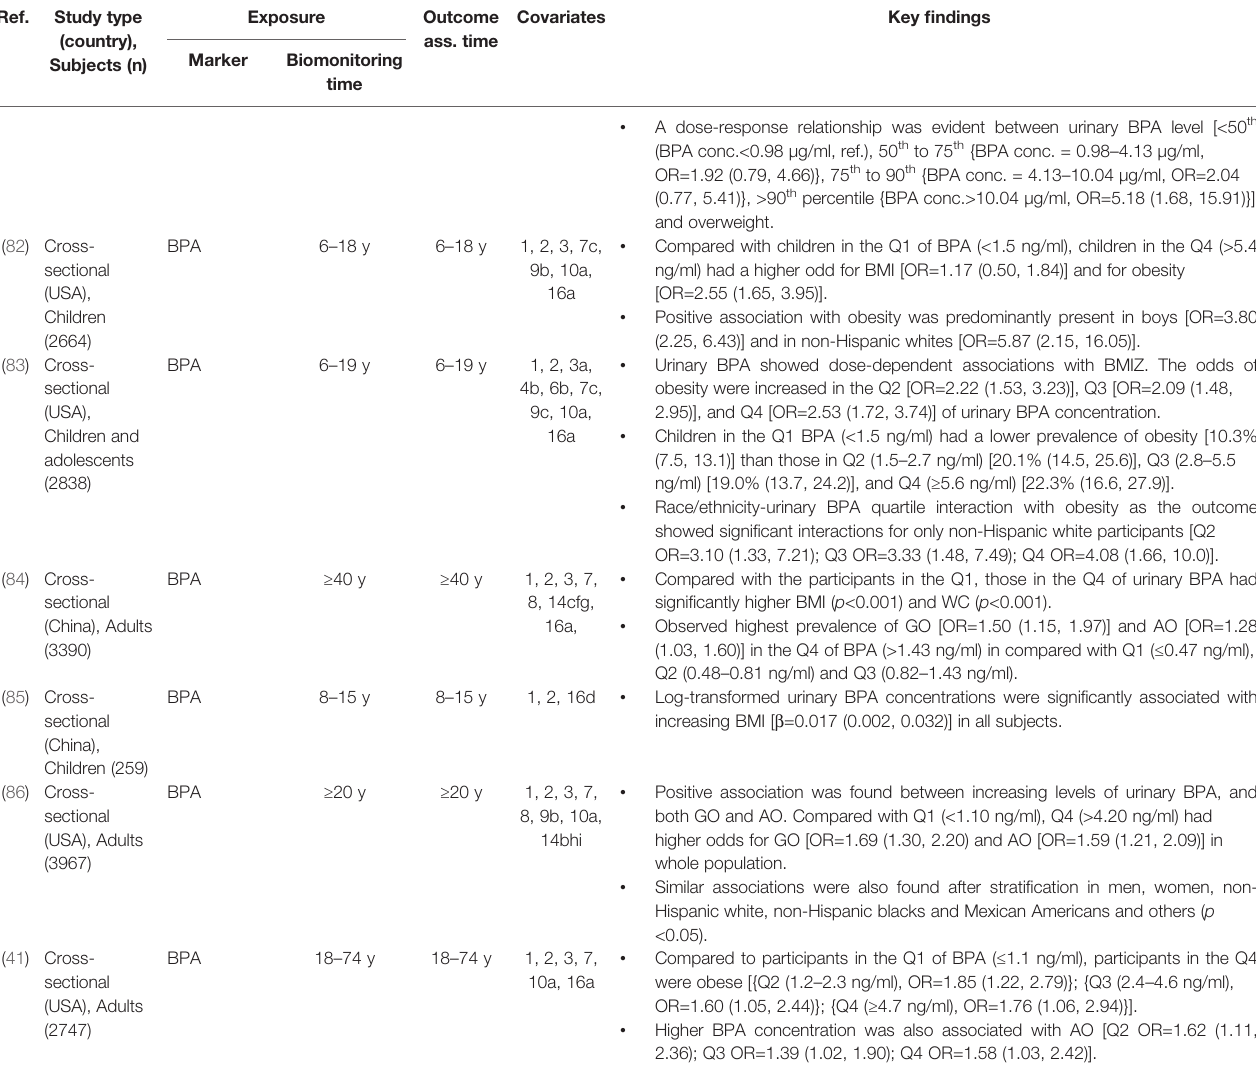
(41) Cross- (cid:129) Compared to participants in the Q1 of BPA ( ≤ 1.1 ng/ml), participants in the Q4